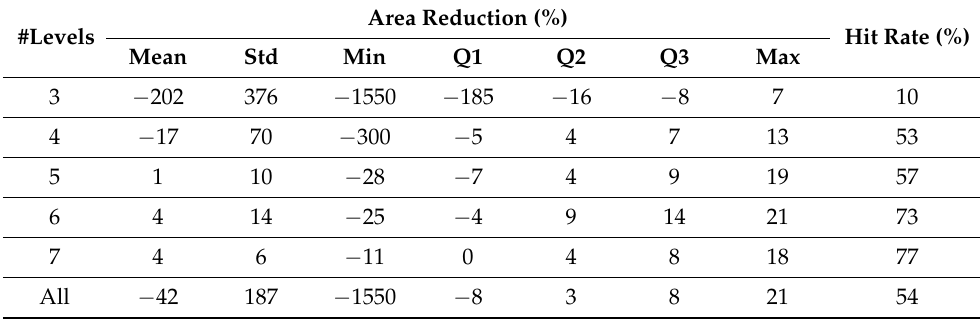
Table 5. Area reduction of CARRY-MAP with respect to VIV-MAP in area optimization.